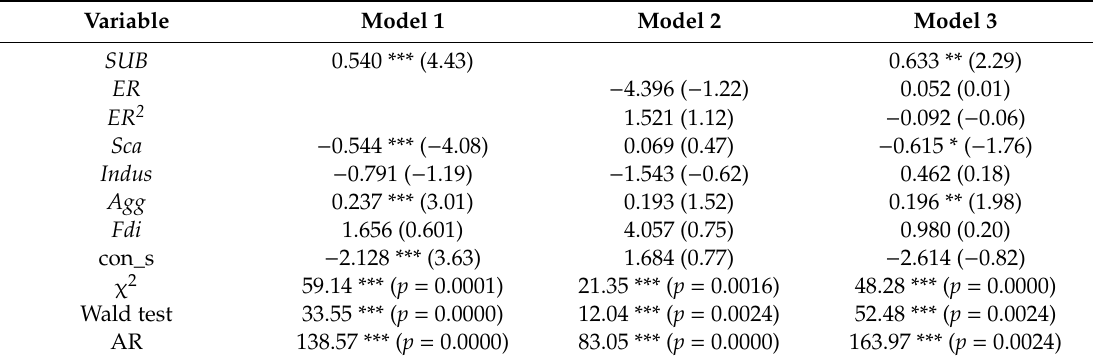
Table 4. Estimation results of the Ivtobit model of the e ff ects of government R&D subsidies and environmental regulations on